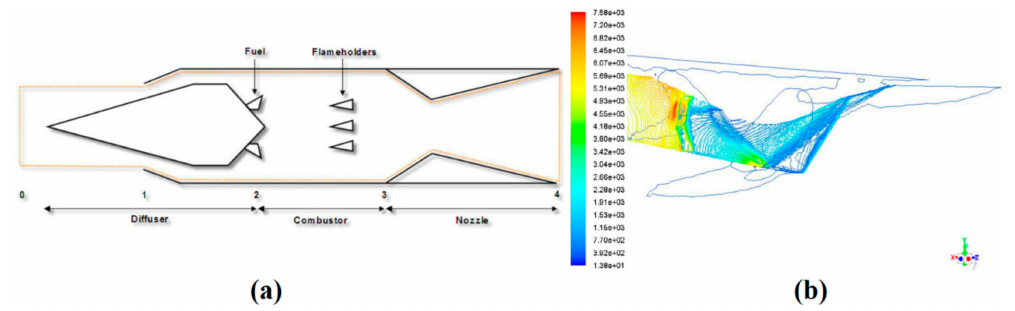
Figure 16. ( a ) Flow stations in a ramjet engine and ( b ) 3D static pressure contours (Pa).